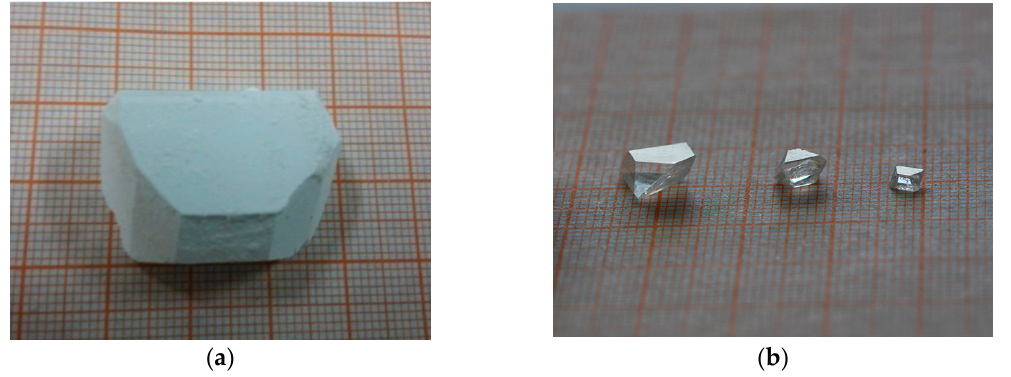
Figure 1. ( a ) Efflorescent TPPB crystal grown by the evaporation of mixed 3:2 solvents of dichloromethane and n-hexane. The crystal has sharp edges and well-defined crystal faces, which indicates an excellent quality before efflorescence; ( b ) TPPB crystal obtained by spontaneous nucleation and growth in water.